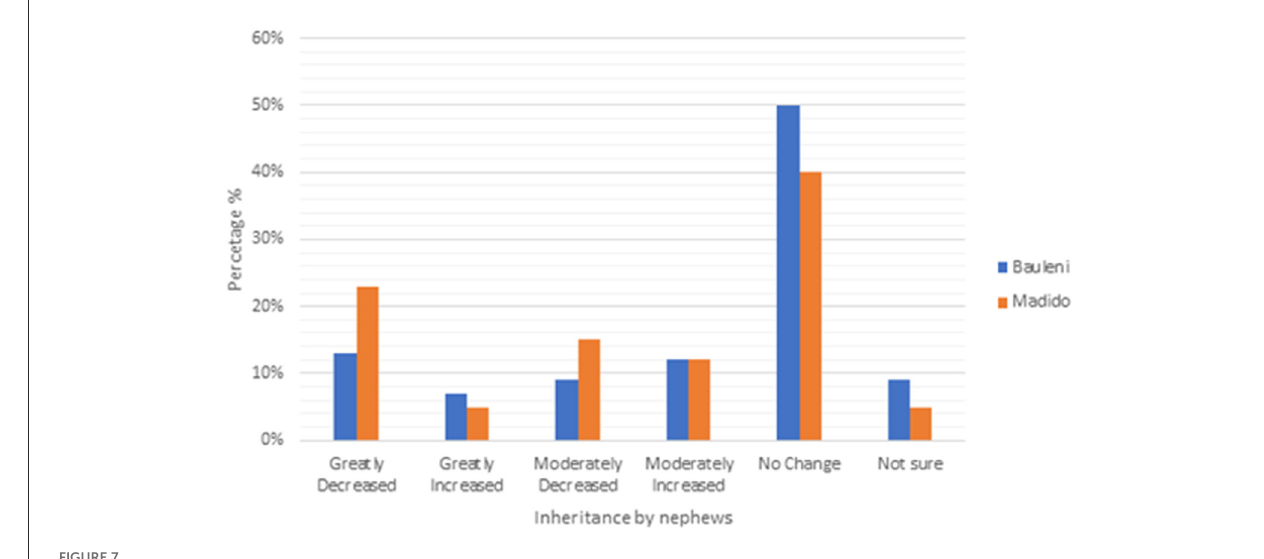
FIGURE7 Inheritance of property rights by nephews in Bauleni and Madido.